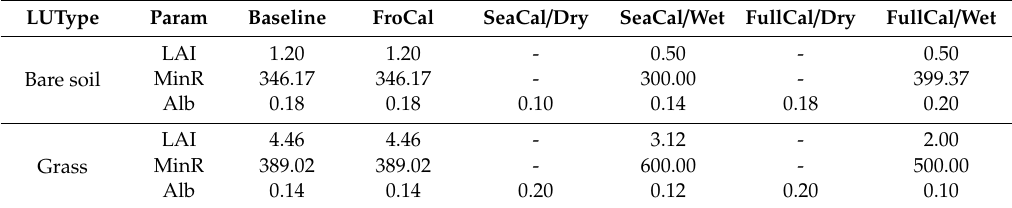
Table 3. Calibrated values of land cover relevant parameters in four calibration steps. Baseline, FroCal, SeaCal and FullCal stand for calibration Steps 1 to 4, respectively; Dry is short for the dry season and Wet the wet season. LUType is short for land use type and Param for parameter. Dash indicates the parameter is not sensitive. Ranges: LAI ( ≥ 0), MinR ( > 0), Alb (0–1). The values are round to two decimal